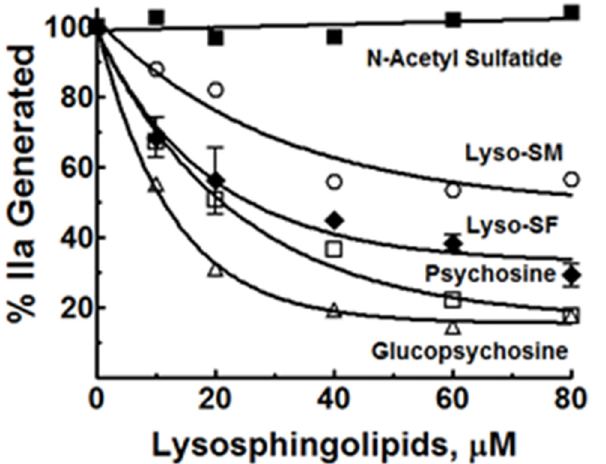
Fig 3. Effect of different analogs of Lyso-SF on II activation by gd-fXa/fVa/PL. The effects of lyso-SF (closed diamonds), psychosine (open squares), glucopsychosine (open triangles), lyso-sphingomyelin (open circles), and N-acetyl sulfatide (closed squares) on the activation of II by gd-fXa/fVa/PL are